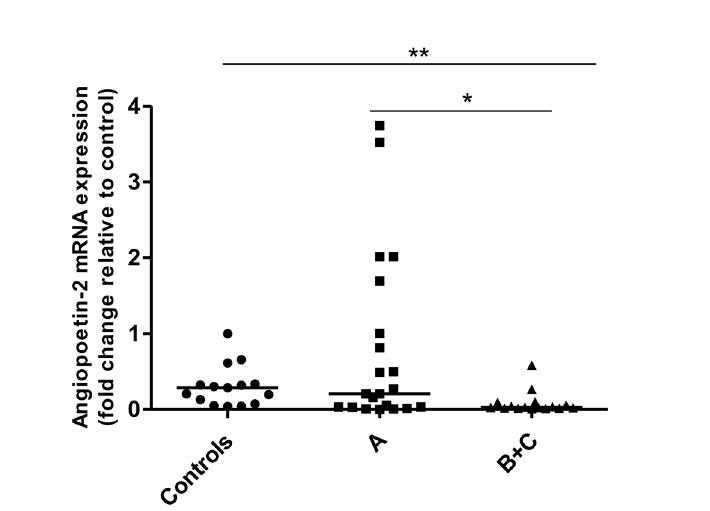
FIGURE 4 - Ang-2 mRNA gene expression in the Controls, CLL Binet A (A) and Binet B+C (B+C). *p=0.002: A versus B+C. **p=0.002: Controls versus Binet B+C. No significant difference was found when comparing Controls and Binet A. Data was presented as median values generated by ANOVA, followed by the Kruskal-Wallis test.